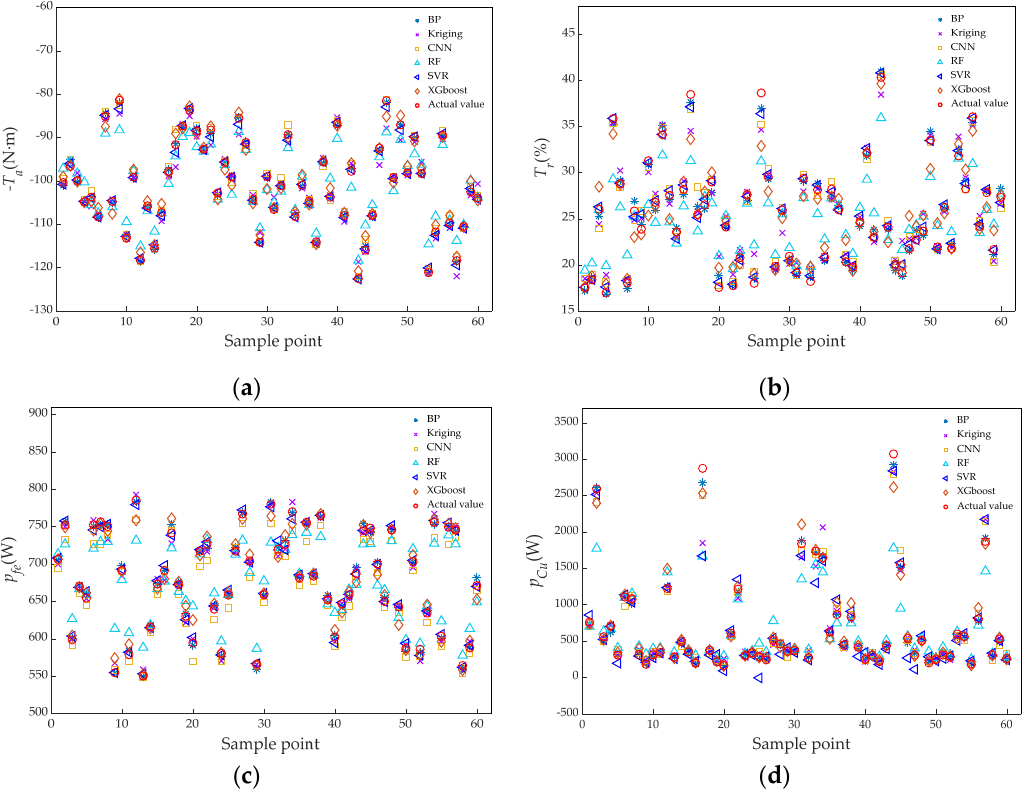
Figure 4. Prediction results of normalization of sample points: ( a ) test results of − T a ; ( b ) test results of T r ; ( c ) test results of p fe ; ( d ) test results of p Cu .